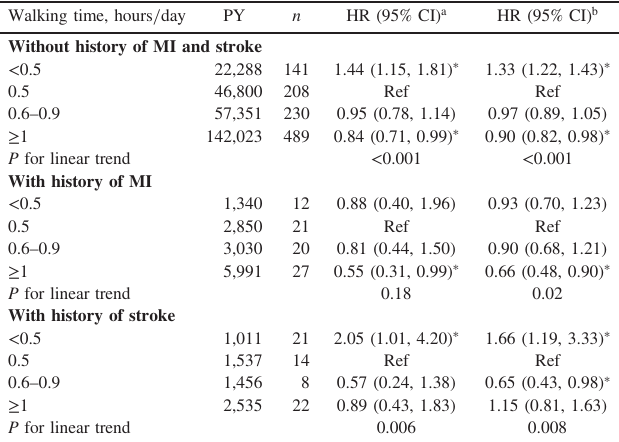
Table 2. Hazard ratios of pneumonia mortality according to walking time among participants with / without a history of MI or stroke Walking time, hours = day